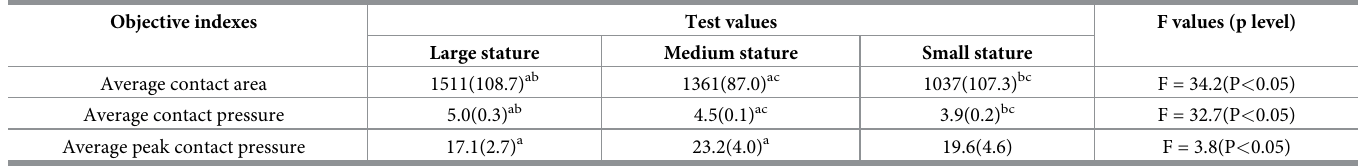
Table 6. Objective experimental test values at three stature under wrapped cushions (values in parentheses indicate a standard error).